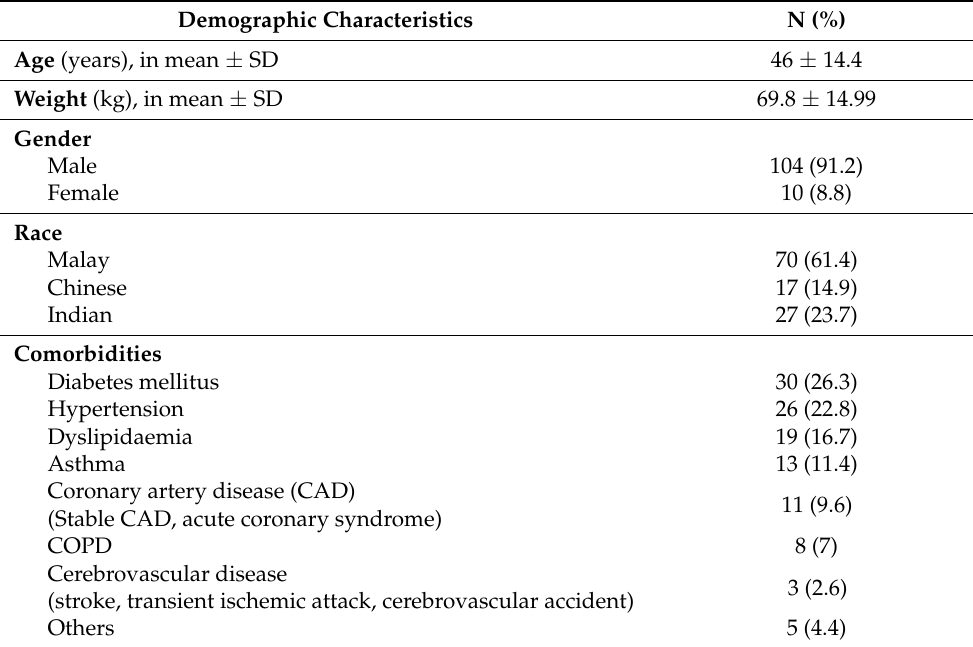
Table 1. Patient demographic characteristics (N = 114).